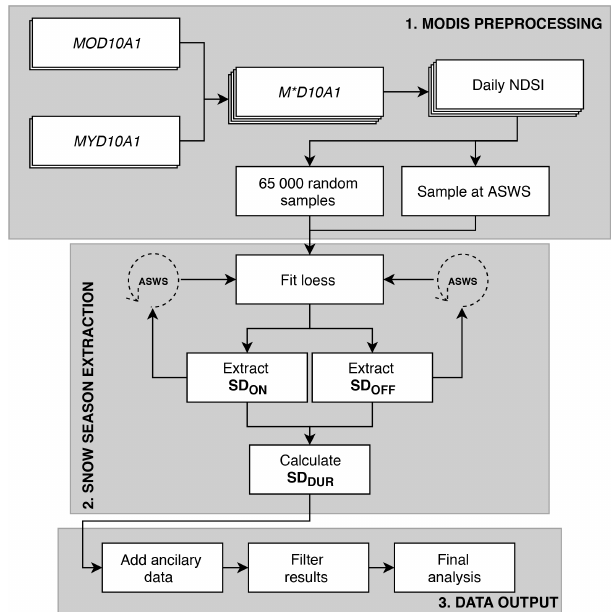
Figure 3. Flowchart of methods used in this study: (1) MODIS pre- processing; (2) snow season extraction; and (3) data